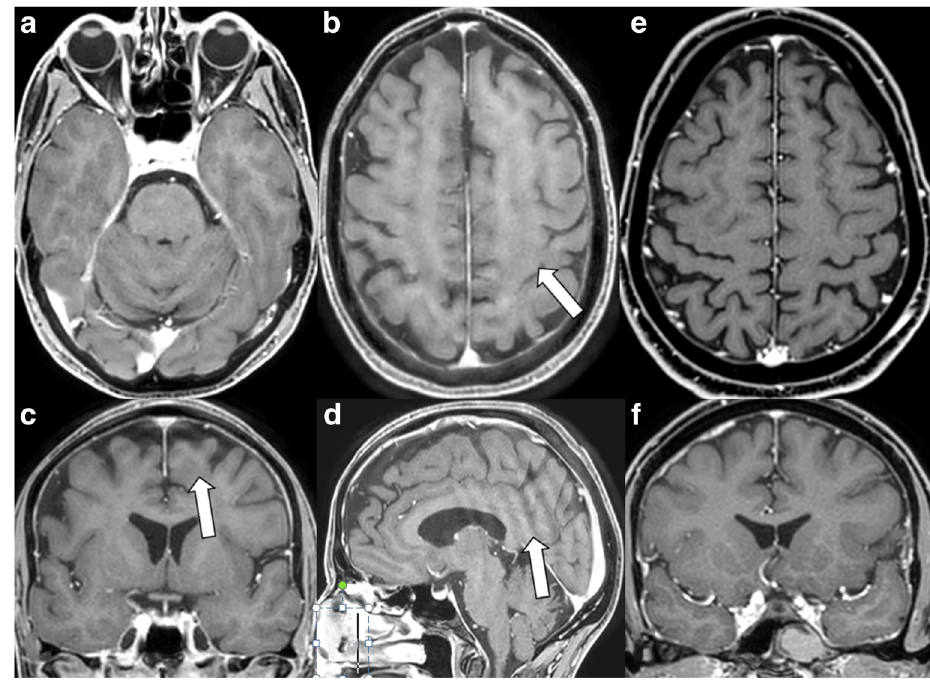
circular rings in phase direction left-right were obtained. In e and f , slight head movements from left to right and, in g and h , severe head movements were performed during scanning. The frequency of the motion artefacts visible as semi-circular rings in phase direction left- right was considerably increased from slight to severe head movements